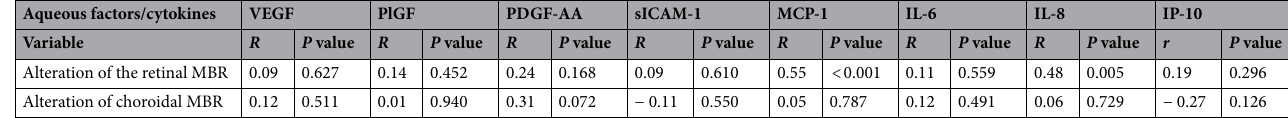
Table 4. Correlations between aqueous humor factors/cytokines and change in MBR 1 month after IRI. VEGF = vascular endothelial growth factor; PlGF = placental growth factor; PDGF =